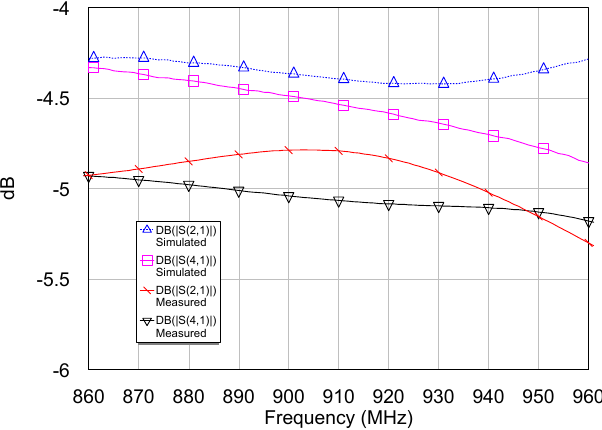
Figure 14. Experimental and simulated insertion losses of the transmitting path.